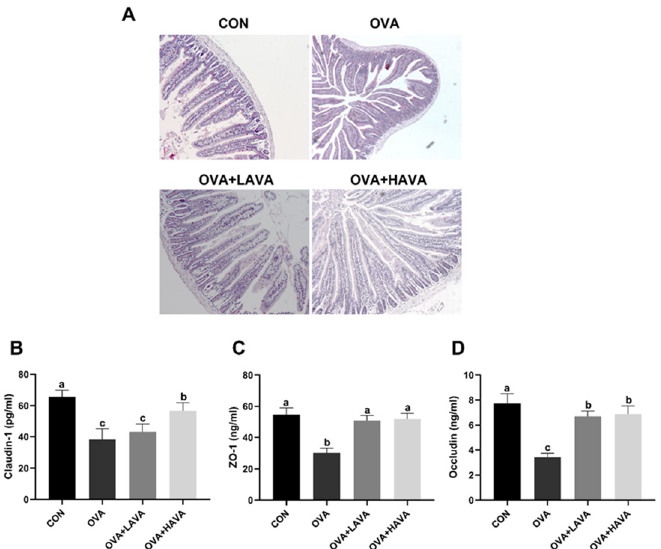
Figure 3. Avenanthramide (AVA) alleviates the intestinal damage induced by ovalbumin (OVA)